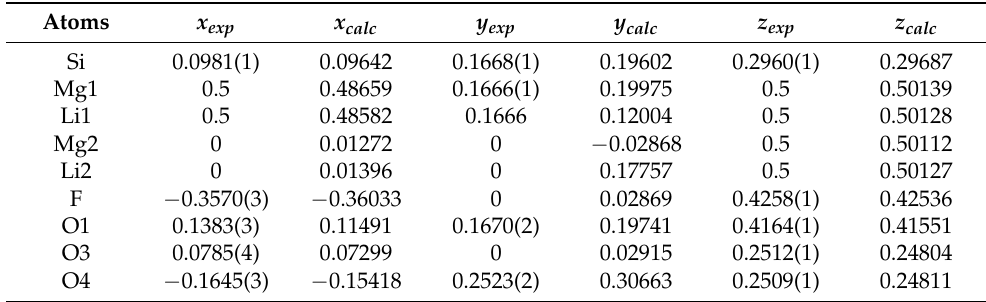
Table 6. Optimized atomic positions in the energetically most stable L model of the TMA-H structure in comparison to the experimental structure [38].